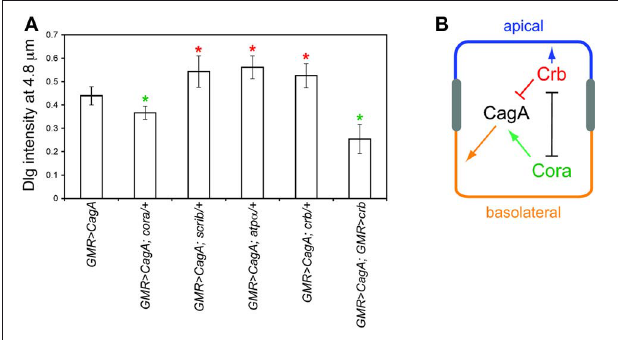
FIGURE 5 | (A) Interactions of several epithelial polarity determinants with CagA, using the Dlg distribution assay described in Figure 3 . Error bars represent standard error. Green asterisks represent mutants that significantly suppress CagA-induced epithelial disruption; red asterisks represent mutants that significantly enhance epithelial disruption ( p < 0 . 05). (B) Model for the interactions of CagA with epithelial polarity determinants Cora and